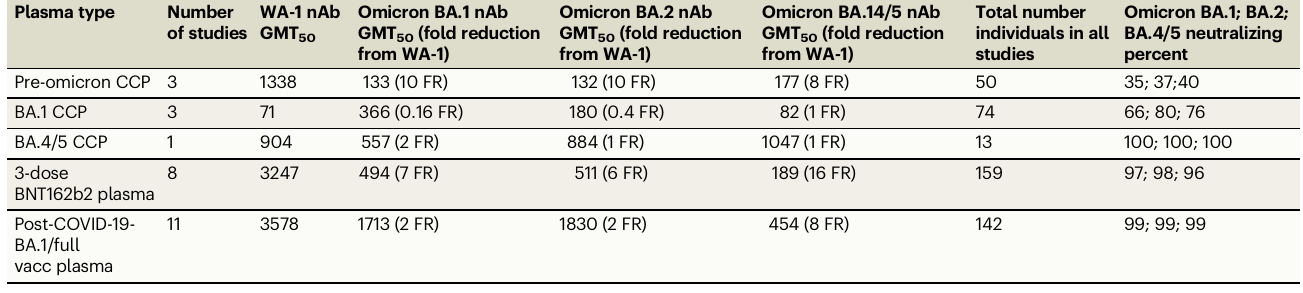
Table 2 | Ef fi cacy of CCP, vaccinee plasma, and Vax-CCP expressed as GMT 50 against Omicron sublineages Plasma